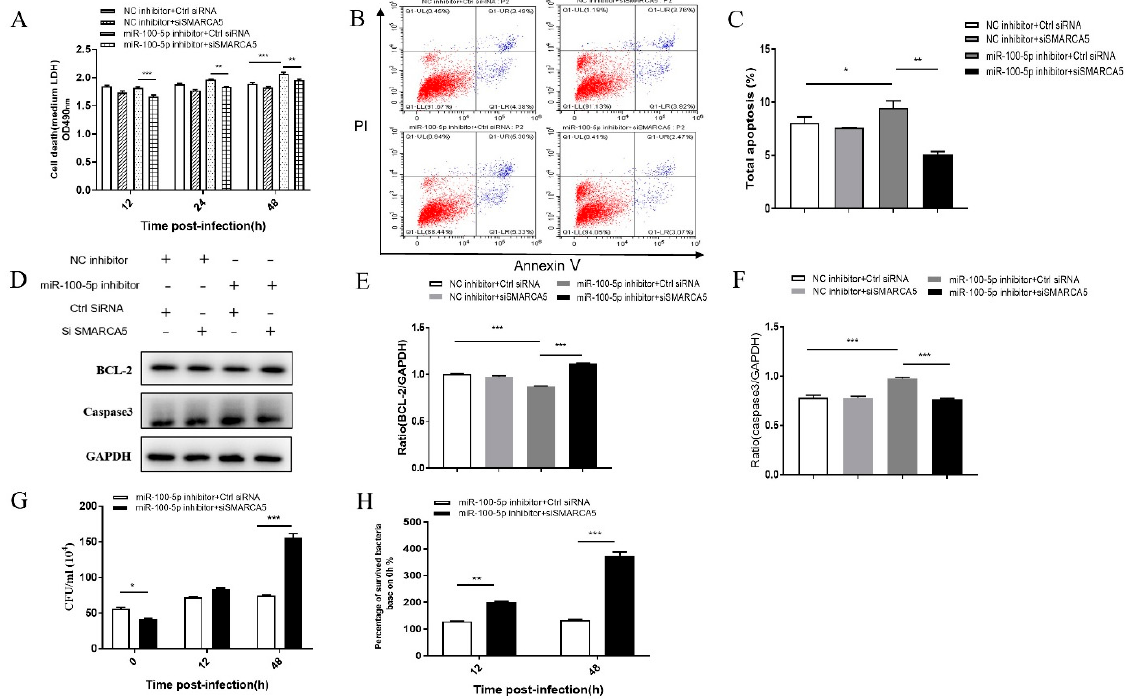
Figure 8. miR-100-5p inhibits apoptosis and promotes BCG survival via SMARCA5 in BCG-infected macrophages. THP-1 cells were cotransfected with NC inhibitor, miR-100-5p inhibitor, siSMARCA5, or control siRNA for 24 h and infected with BCG at an MOI 10 for 8 h. There were four groups: cotransfected NC inhibitor and siRNA control, cotransfected NC inhibitor and siSMARCA5, cotransfected miR-100-5p inhibitor and siRNA control, and cotransfected miR-100-5p inhibitor and siSMARCA5. ( A ) Medium LDH release detected at 12, 24, and 48 hpi with OD490 nm. ( B , C ) Cell apoptosis identified by flow cytometry at 12 hpi. The total apoptosis rate was analyzed by GraphPad Prism. ( D ) Caspase-3 and Bcl-2 protein levels detected by Western blotting assay. ( E , F ) Relative protein expression ratios analyzed using ImageJ with normalization to GAPDH. ( G , H ) Number of intracellular bacteria (CFU/mL) determined at 48 hpi. The percentage of surviving intracellular bacteria based on 0 hpi was analyzed. Data are from three independent experiments with biological duplicates in each (( A – C , G , H ); mean ± s.e.m. of n = 3 duplicates) or representative of three independent experiments (( D – F ), mean ± s.e.m). * p < 0.05; ** p < 0.01; *** p <